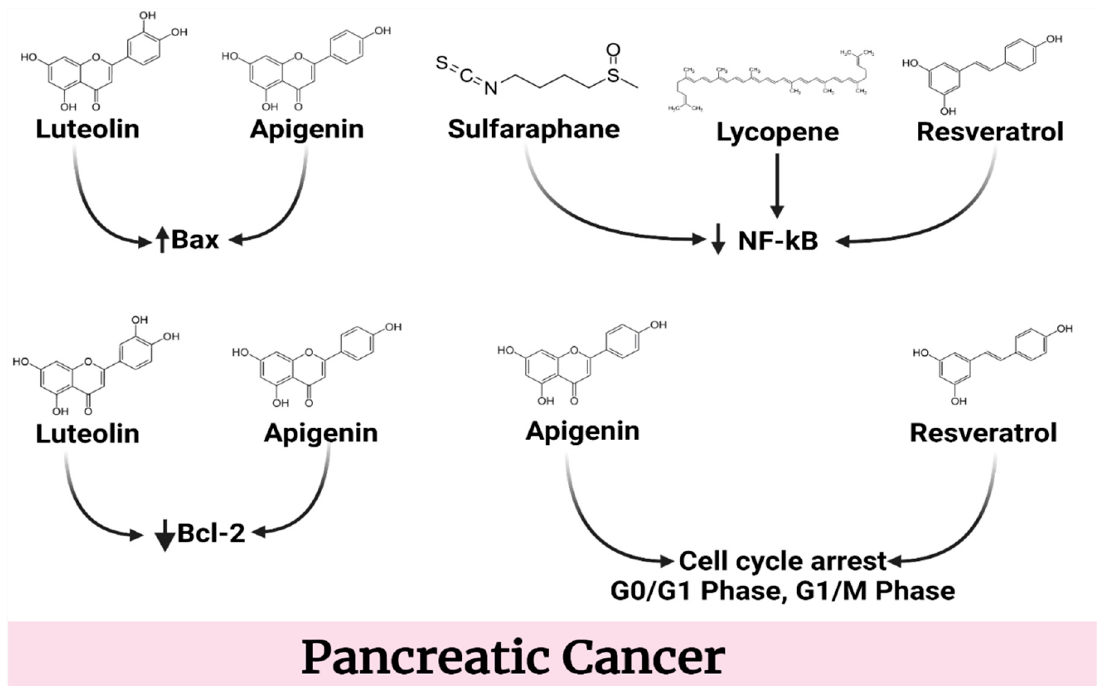
Figure 6. Illustration representing the probable sites of blockade by small molecules in pancreatic cancer.